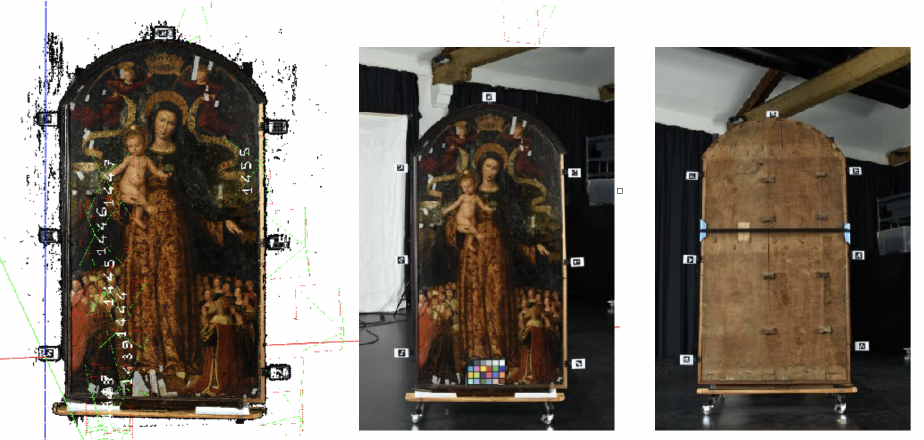
Figure 4. Example of automated scaling and orientation of wood painting base on experimental double sided coded-targets